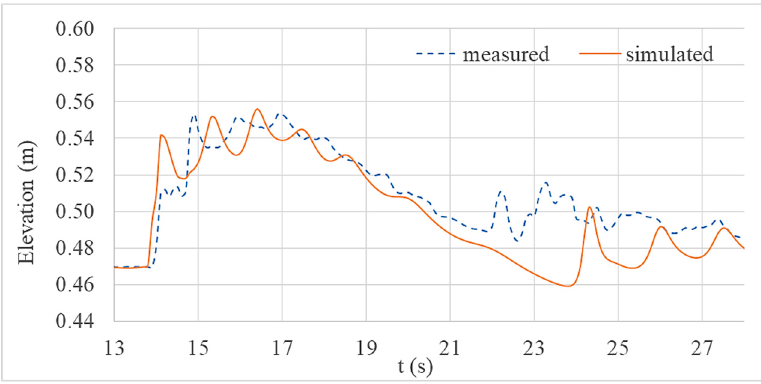
Figure 6. Comparison of water level variations at location C.